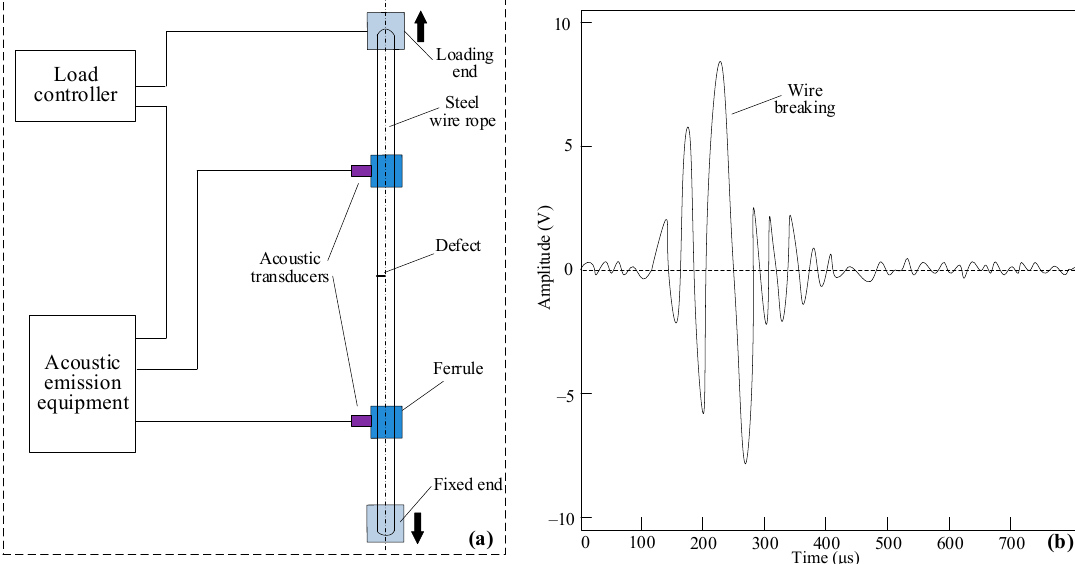
Figure 5. Acoustic emission detection for steel wire rope [61]. ( a ) Detection system schematic diagram; ( b ) sketch map for waveform of defects and wire breaking signal.